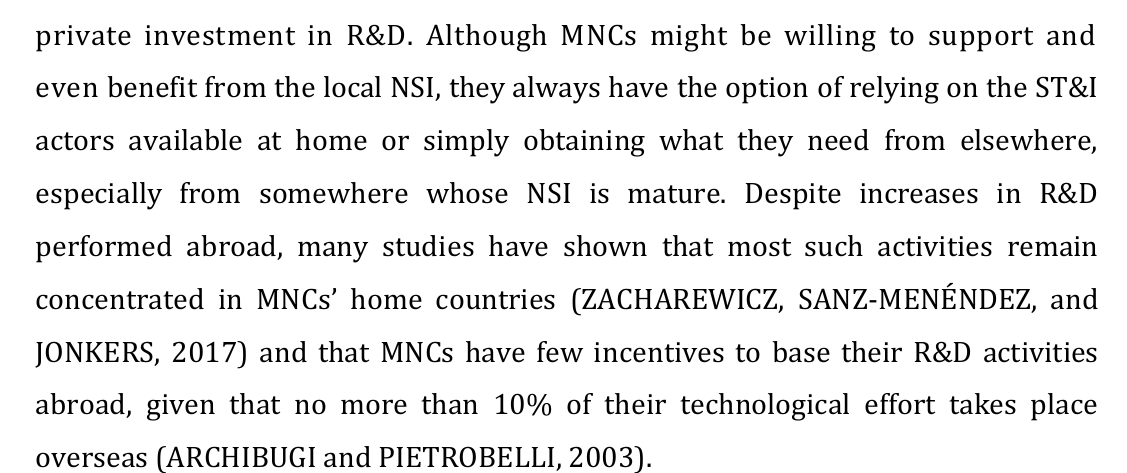
Argentina Brazil